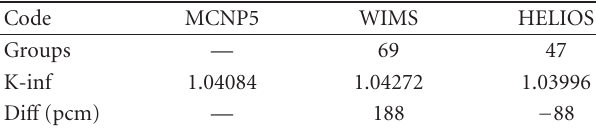
Table 3: Results: idealized rodded lattices—steel.